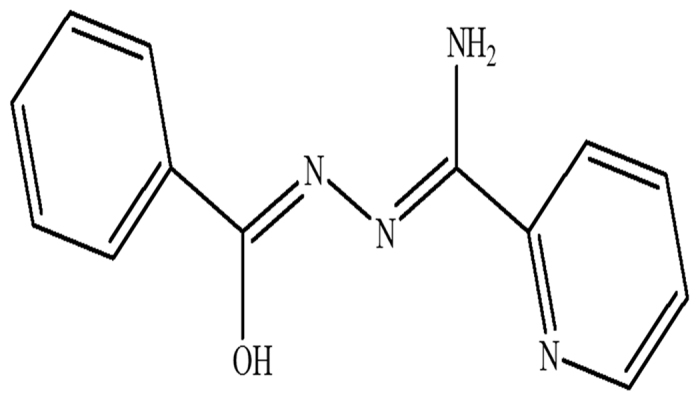
N3-benzoylpyridine-2-carboxamidrazone (Hbpad).